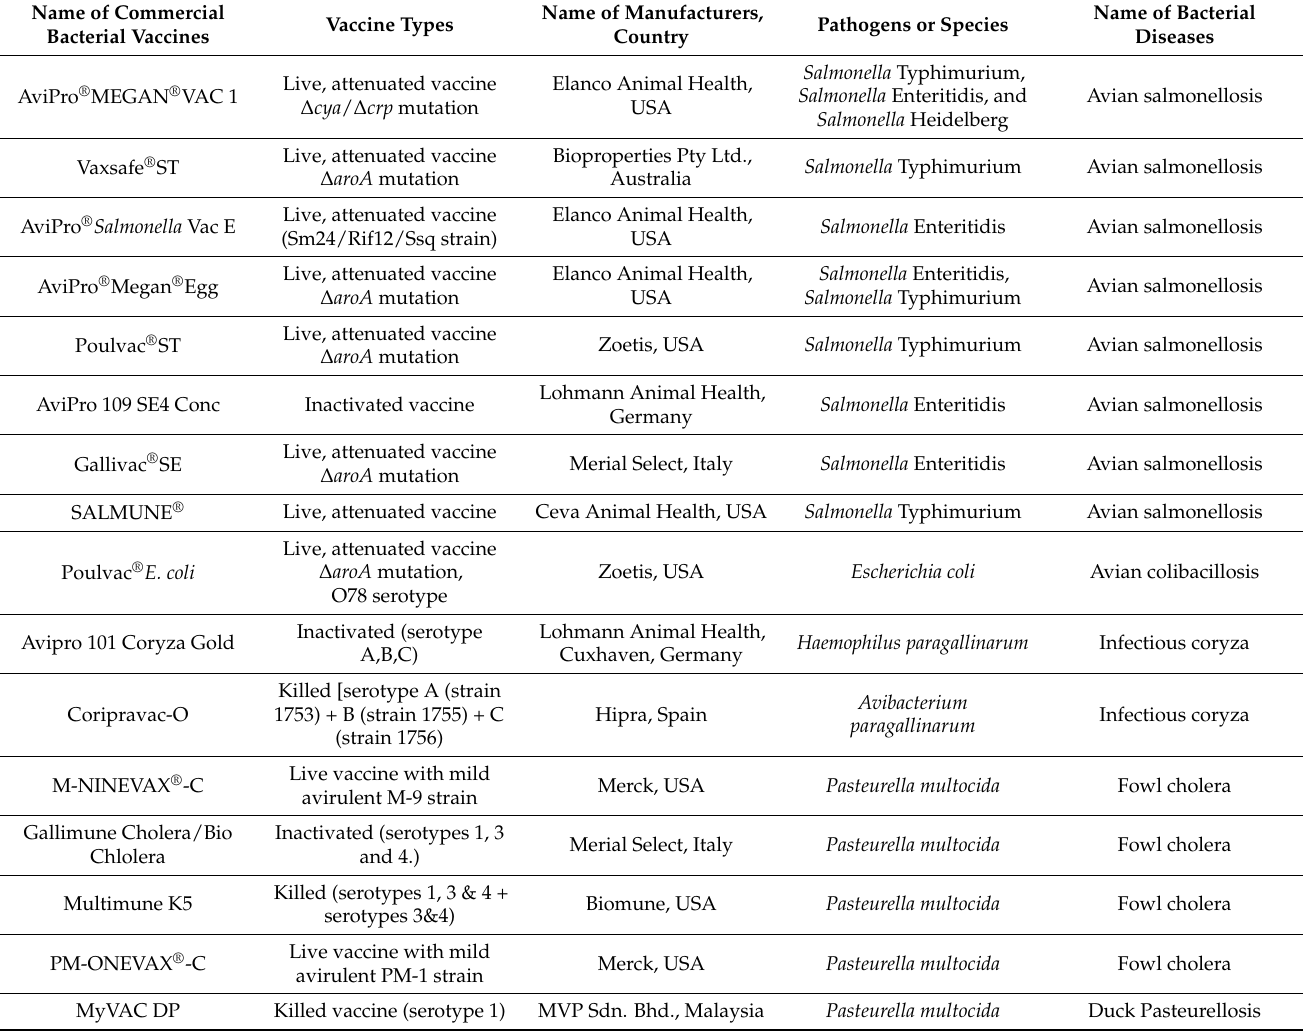
Table 2. List of commercially available bacterial vaccines against different common bacterial diseases in poultry production